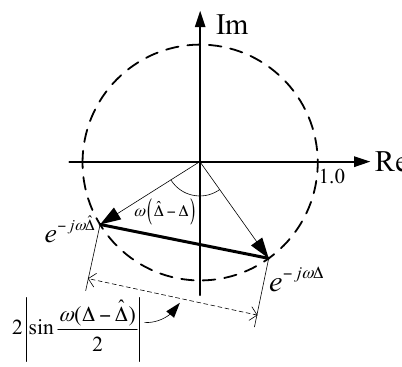
∆ − e − j ω ˆ ∆ ] illustrated in the complex Figure 4. The magnitude response of illustrated in the complex plane. Figure 4. The magnitude response of [ e − j ω